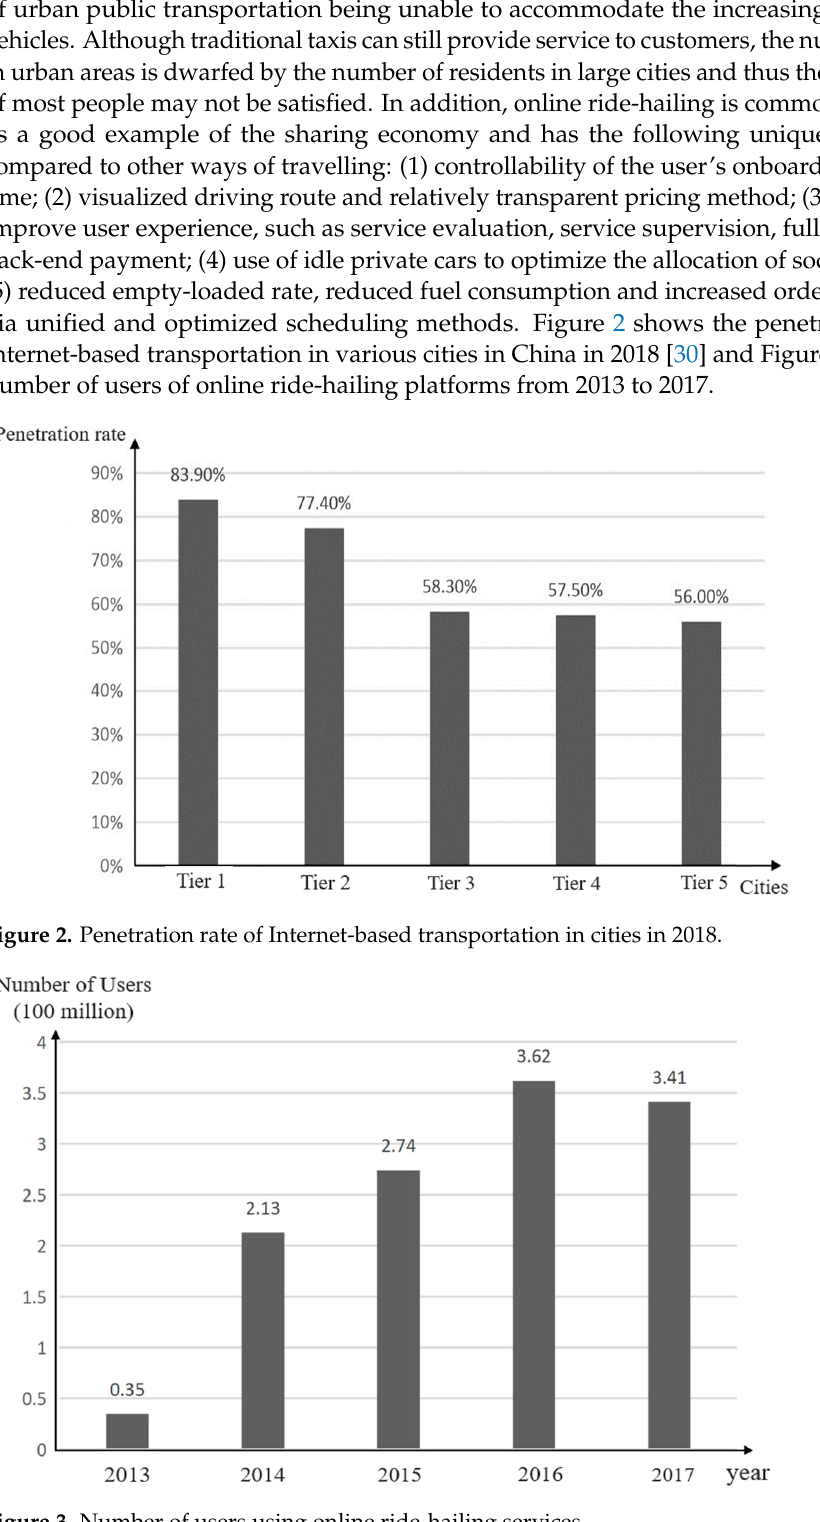
Figure 1. Structure of the paper.